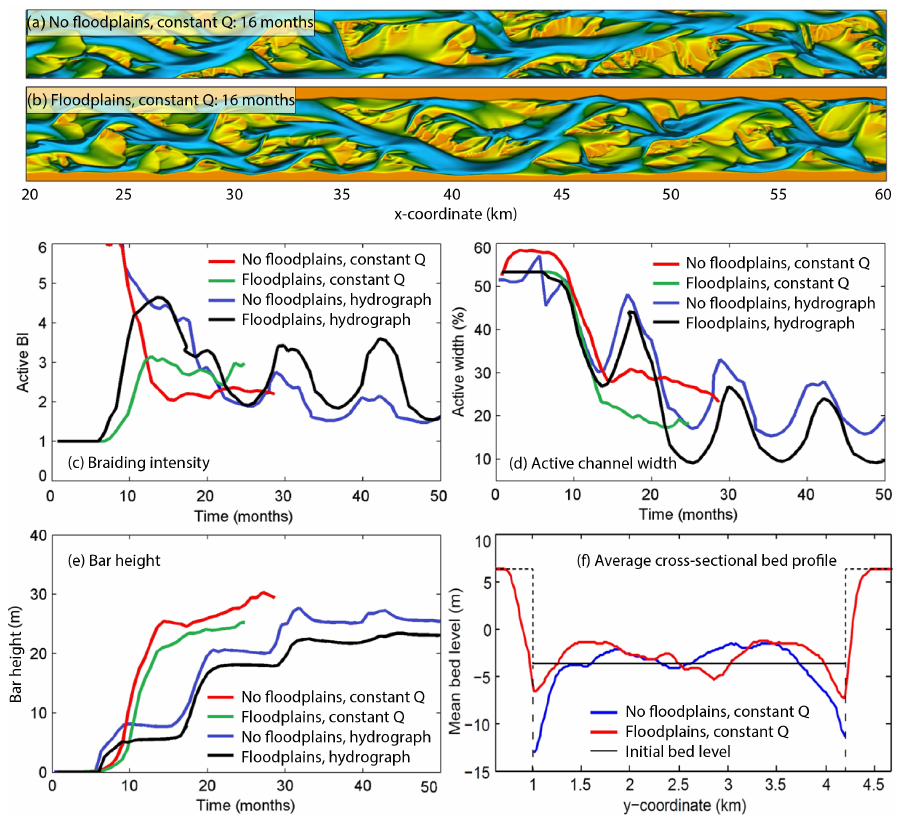
Figure 4. Evolution of the braided channel network and bar pattern in case of (1) constant Q and fixed walls, (2) constant Q and erodible floodplains, (3) hydrograph and fixed walls, and (4) hydrograph and erodible floodplains. Panels (a) – (b) show the bed level after 16 months for cases (1) and (2). Panels (c) – (e) show reach-average channel statistics, and (f) shows average cross-sectional bed level profiles after 16 months for cases (1) and (2).